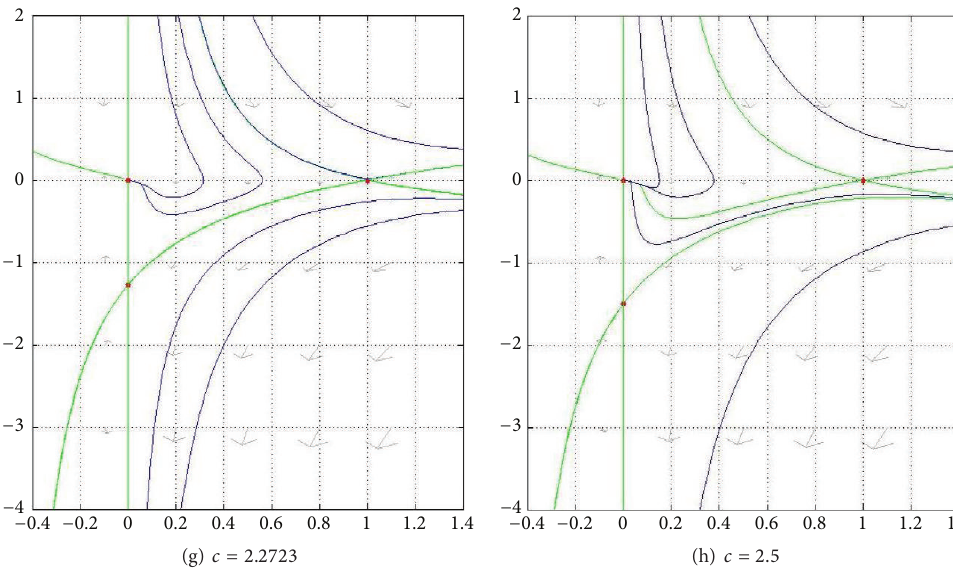
Figure 12: Phase portrait of (40a) and (40b) for eight values of 𝑐 ; (a)–(h) contemplate the first subcase ( 1 = ℎ 󸀠 (0) > 𝑐 ); (e) shows 𝑐 = 1 (only two equilibria); and (f)–(h) contain the second subcase ( 𝑐 > ℎ 󸀠 (0) = 1 ). Here 𝑘 = 𝛾 = 𝛼 = 1 , 𝛽 = 2 . Red points are equilibrium points. Green curves are nullclines and blue curves are